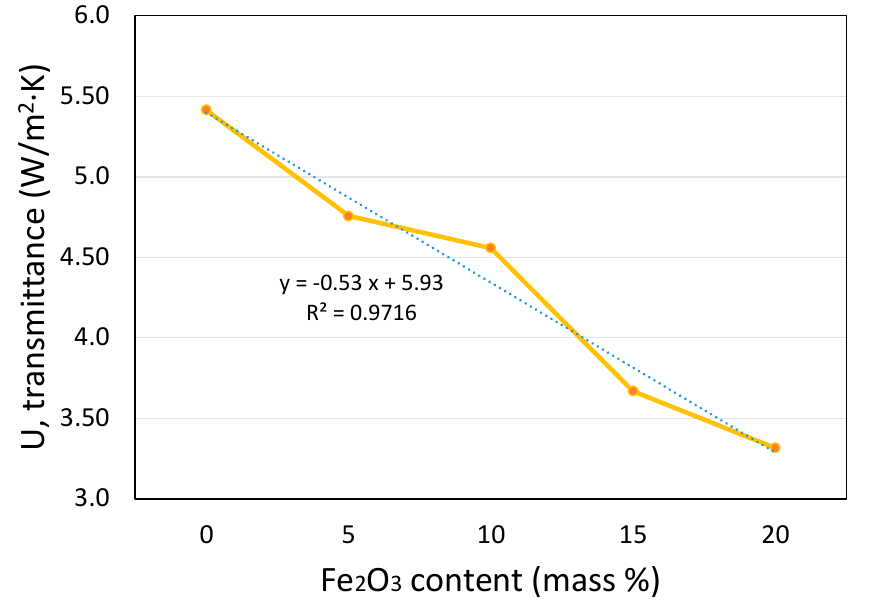
Figure 9. Transmittance of the samples of lime mortar with different iron (III) oxide content.